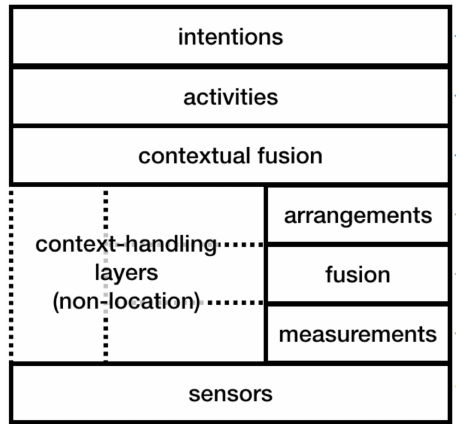
Figure 1. The Location Stack: A layered software engineering model for ubicomp apps developed by Hightower et al.